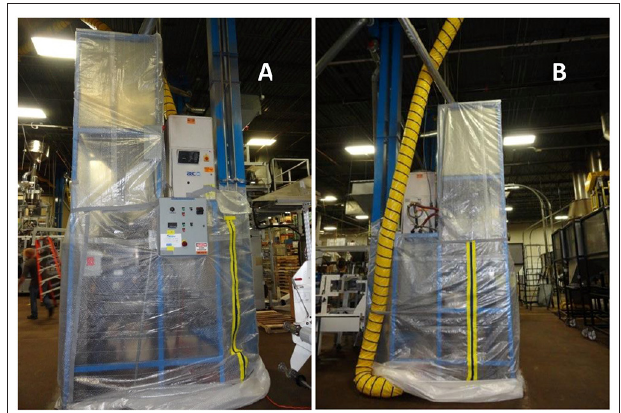
FIGURE 1 | Images of Grinder B (A) front view and (B) side view on 2nd and 3rd day of sampling with enclosure in place. One sampler was located inside the enclosure and the second sampler was located immediately outside the enclosure. The yellow and black stripes are the zippers to allow employee access and the yellow flexible tube is a ventilation duct.